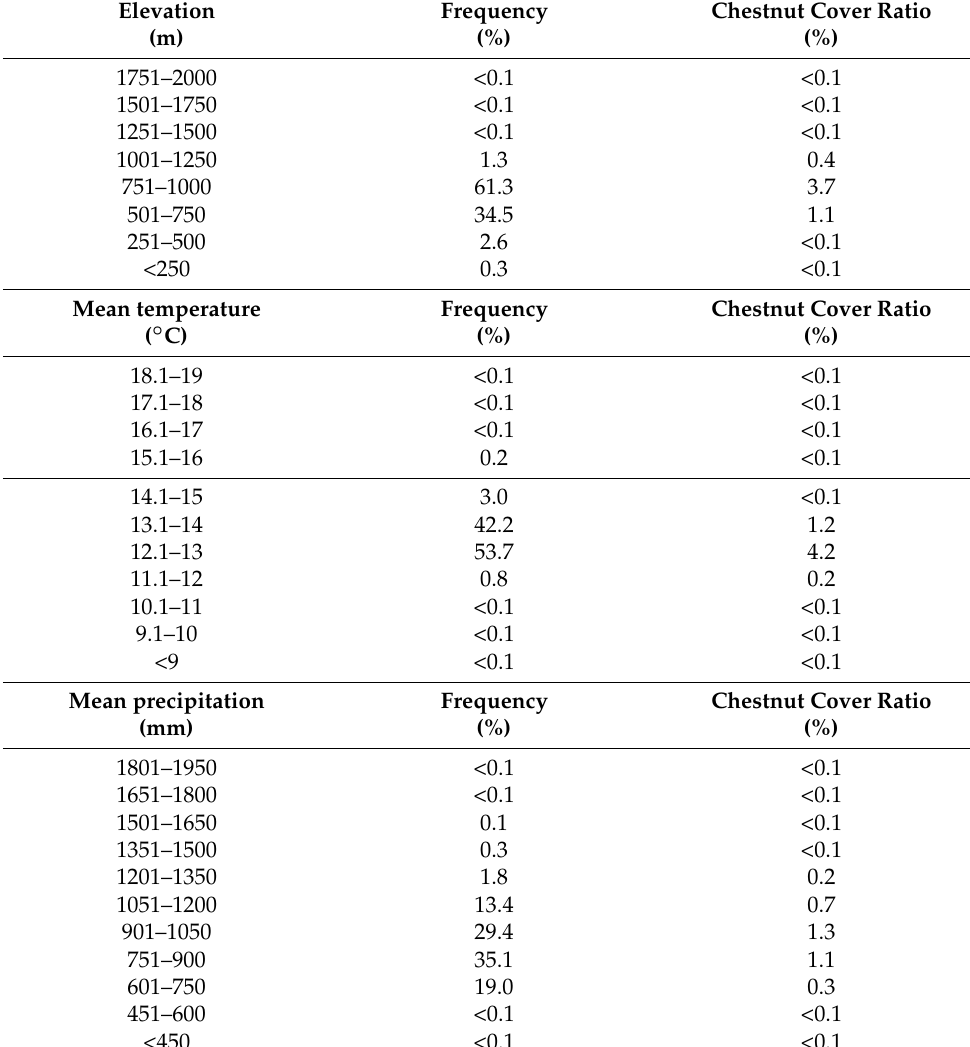
Table 2. Characterization of chestnut tree distribution in Portugal (frequency in %) as a function of different classes of elevation, annual mean accumulated precipitation and temperature. The chestnut tree land cover ratios for each class are also